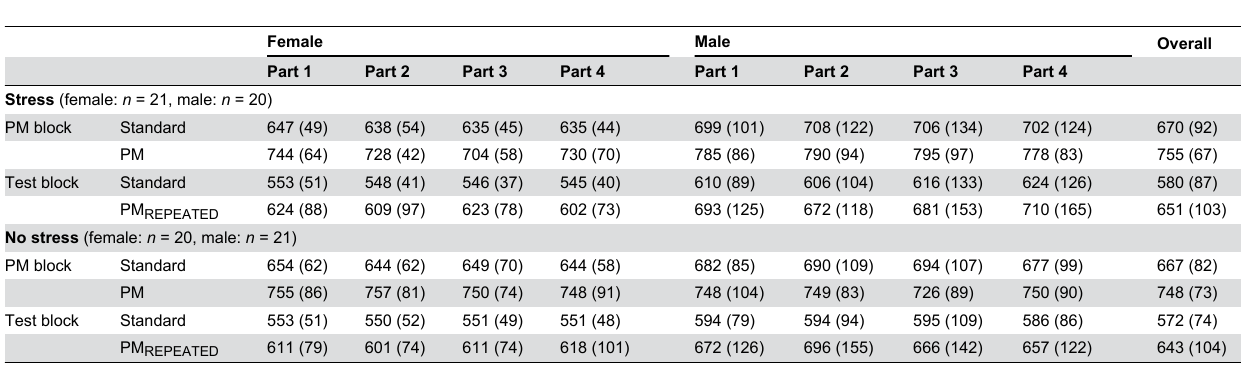
Table 1. Mean response Times (in ms) for the prospective memory (PM) Block and the Test Block by Trial type (PM Block: Standard, PM; Test Block: Standard, PM ) and treatment (stress, No stress), and with the additional factors sex REPEATED (female, male) and Time (Part 1 to Part